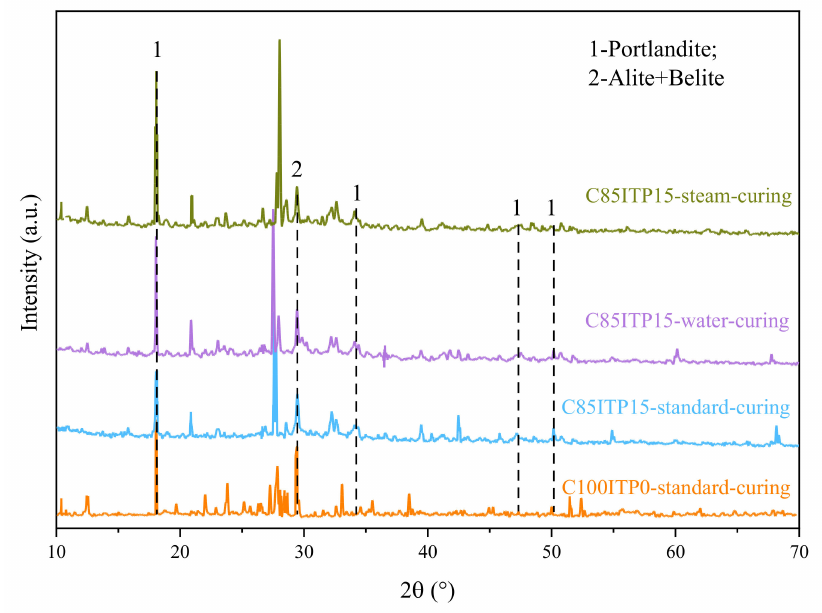
Figure 5. Hydration products of C100ITP0 under standard curing and C85ITP15 under different curing procedures (only the characteristic peaks of portlandite, alite, and belite are marked in the